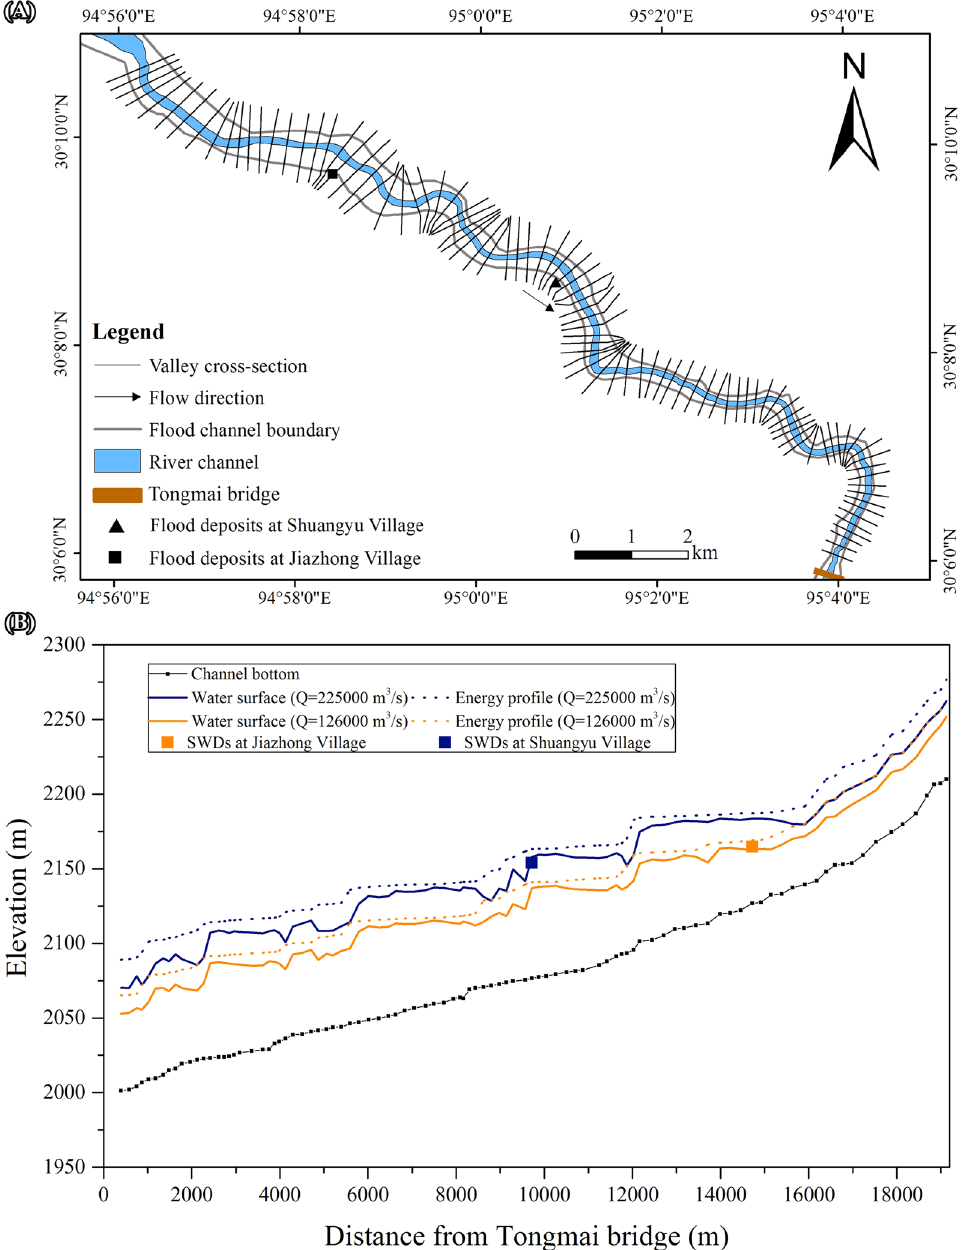
Figure 5. ( A ) The locations of 97 cross-sections used in the HEC-RAS mapper component of HEC-RAS 5.0.7 for the 1D step-backwater computation from the breached dam to the bridge. ( B ) Longitudinal profiles of the water surface and energy grade elevations calculated using the step-backwater method. Peak discharges of 126,000 m 3 /s and 225,000 m 3 /s provided the best approximation for the levels of the SWDs at Jiazhong and